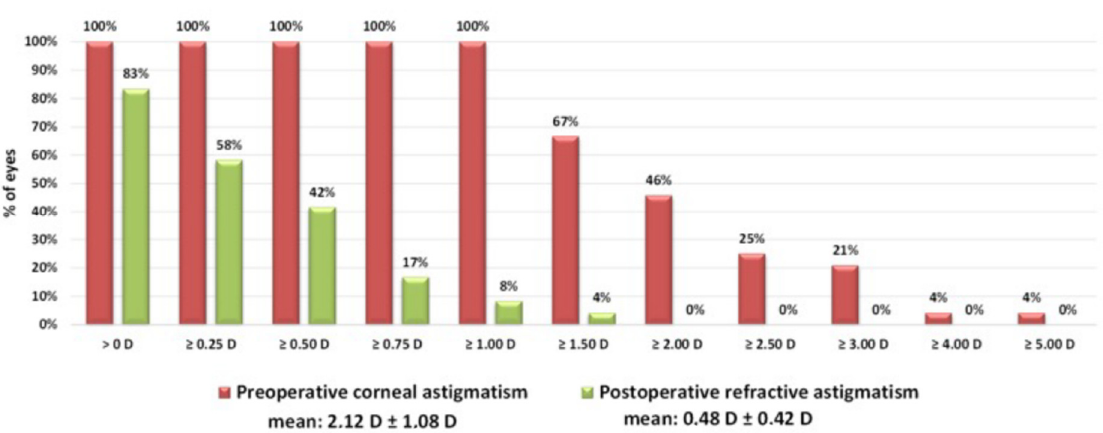
Figure 1. Cumulative histogram of the magnitudes of the preoperative corneal astigmatism and the postoperative refractive astigmatism at the corneal plane in the digital group ( n = 24).